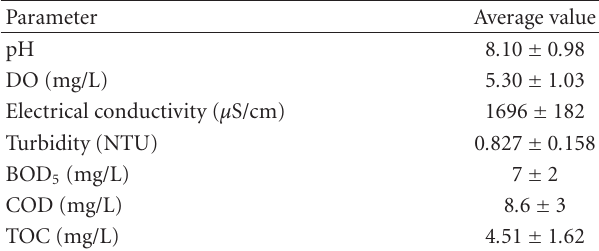
Table 1: Physicochemical characterization of sampled